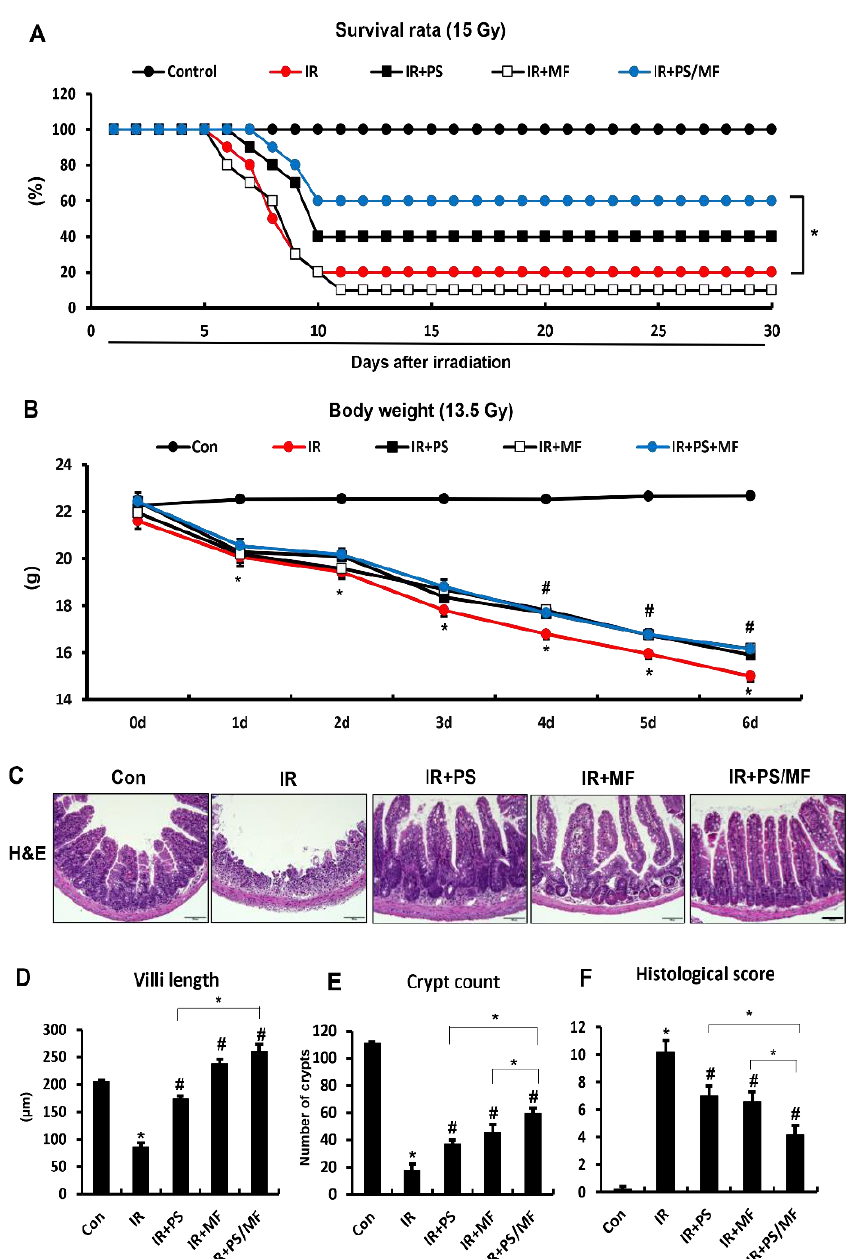
Figure 1. Effects of combined pravastatin and metformin treatment on survival rate and radiation- induced intestinal injury in the mouse model. ( A ) Survival Rate of control (Con), irradiated (IR), pravastatin-treated IR (IR + PS), metformin-treated IR (IR + MF), combined PS and MF-treated IR (IR + PS/MF) mice after abdominal irradiation of lethal dose of 15Gy. n = 10 mice per group ( B ) Body weights of Con, IR, IR + PS, IR + MF, IR + PS/MF groups after abdominal radiation of sub-lethal dose of 13.5 Gy. ( C ) Hematoxylin & Eosin (H&E) stain, ( D ) villi length, and ( E ) crypt count of 13.5 Gy irradiated small intestine after 6 days. Bar = 100 µ m. ( F ) Histological score defined by the degree of maintenance of epithelial architecture, crypt damage, vascular dilation, and infiltration of inflammatory cells in the lamina propria (0 = none, 1 = mild, 2 = moderate, 3 = high) of small intestine from Con, IR, IR + PS, IR + MF, IR + PS/MF groups. Data are presented as the mean ± standard error of the mean; n = 5–6 mice per group. * p < 0.05 compared to the control; # p < 0.05 compared to the IR group.